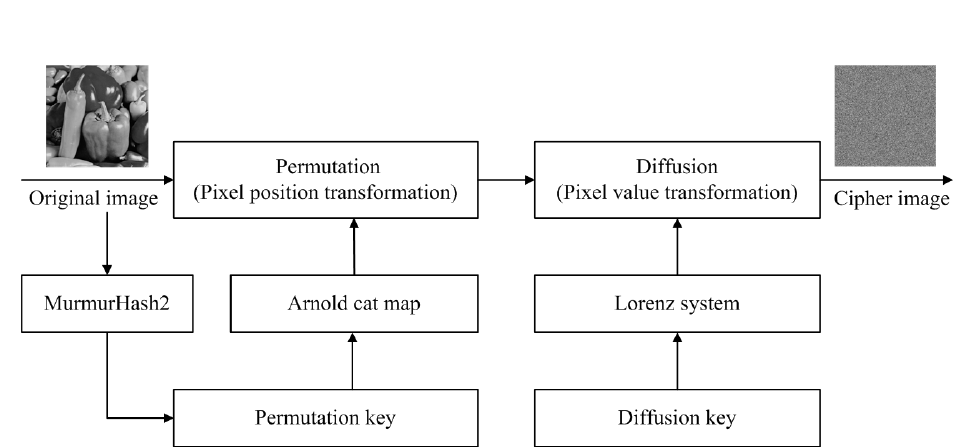
Fig. 1. Architecture of the proposed